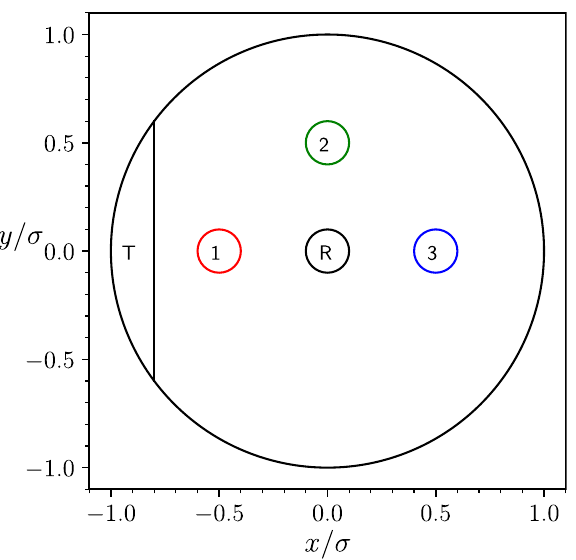
Figure 1. Experimental and simulation setup. The death zone R is a circular region at the center of the Petri dish, while the safe region T is a circular segment on the left side of the dish. The committor is evaluated in the three circular regions labeled from 1 to 3. Here (and in the following) R and T refer respectively to the projections on the physical space of the reactant R and target T which are generally defined in the whole configuration space. The shape, position, and size of regions R and T in the Petri disk where arbitrarily chosen in order to ensure that the system’s configuration does not display any symmetry. The size of the R and T regions have been chosen large enough to guarantee the collection of sufficient statistics in simulations and in our experiments with camphor